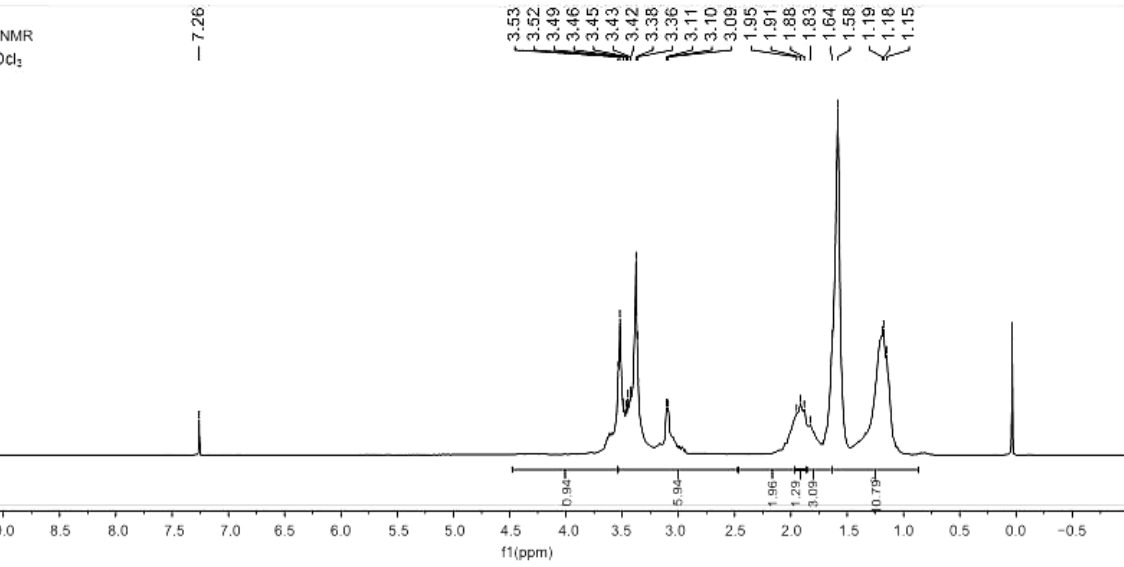
Figure 5. 1 HNMR of the synthetic copolyether.